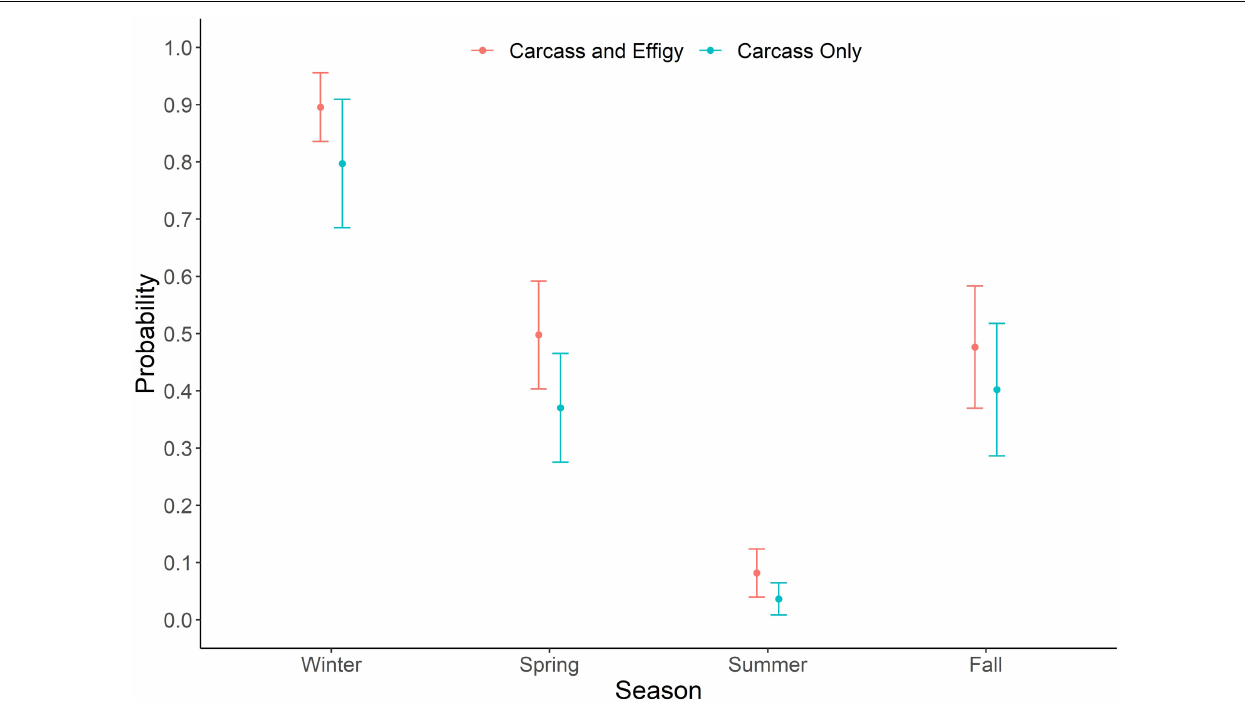
FIGURE 11 | Probability of beaching by season ± 1 standard error for carcass and effigy and carcass only models. TABLE 4 | Summary of seasonal mean water temperature, distance travelled and time traveled for beached objects [carcasses ( n = 64) and effigies ( n = 56)] by season [(January–February), spring (March–June), summer (July–September), and fall (October–December)]. Beaching probability ranges include results from both carcasses ( n = 163) and effigies ( n = 100) combined (higher values) and carcasses only released at deployment sites (A, B, and C). Season Mean water Mean distance Range distance Mean travel Range travel Beaching temperature ( ◦ C) travelled (km) travelled (km) time (days) time (days)